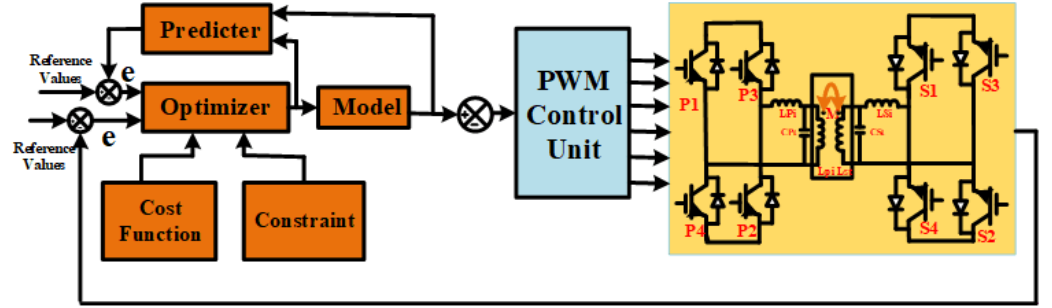
Figure 11. Model Predictive Control-interfaced BWPT system.